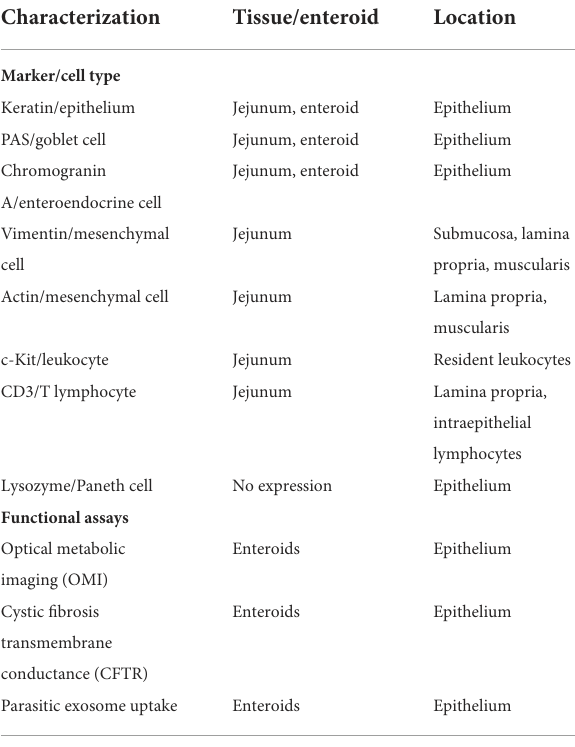
TABLE 5 Phenotypic/functional characterization of canine organoids and whole jejunum [modified from (237)]. Characterization